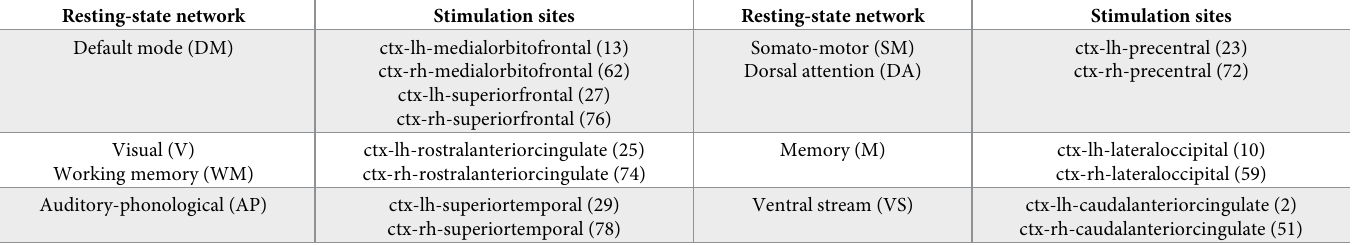
Table 1. Stimulation sites to validate RS networks. This table shows stimulus sites able to reproduce the best-matched response patterns with brain activation patterns in each RS network. The number in parentheses indicates the node index. Resting-state